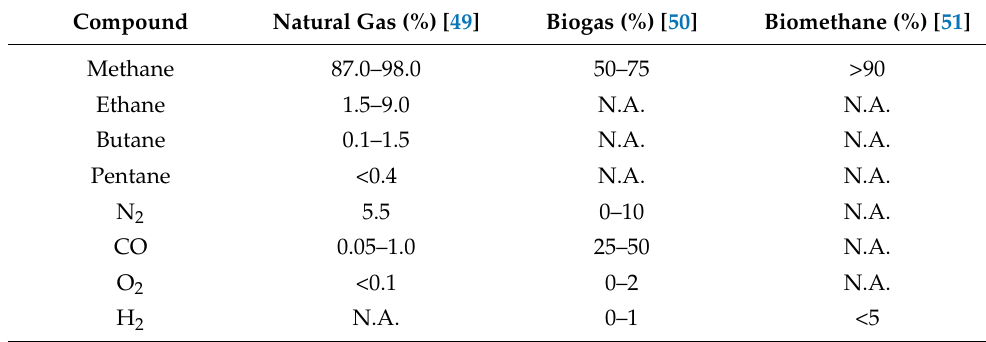
Table 5. Comparison of natural gas, biogas, and